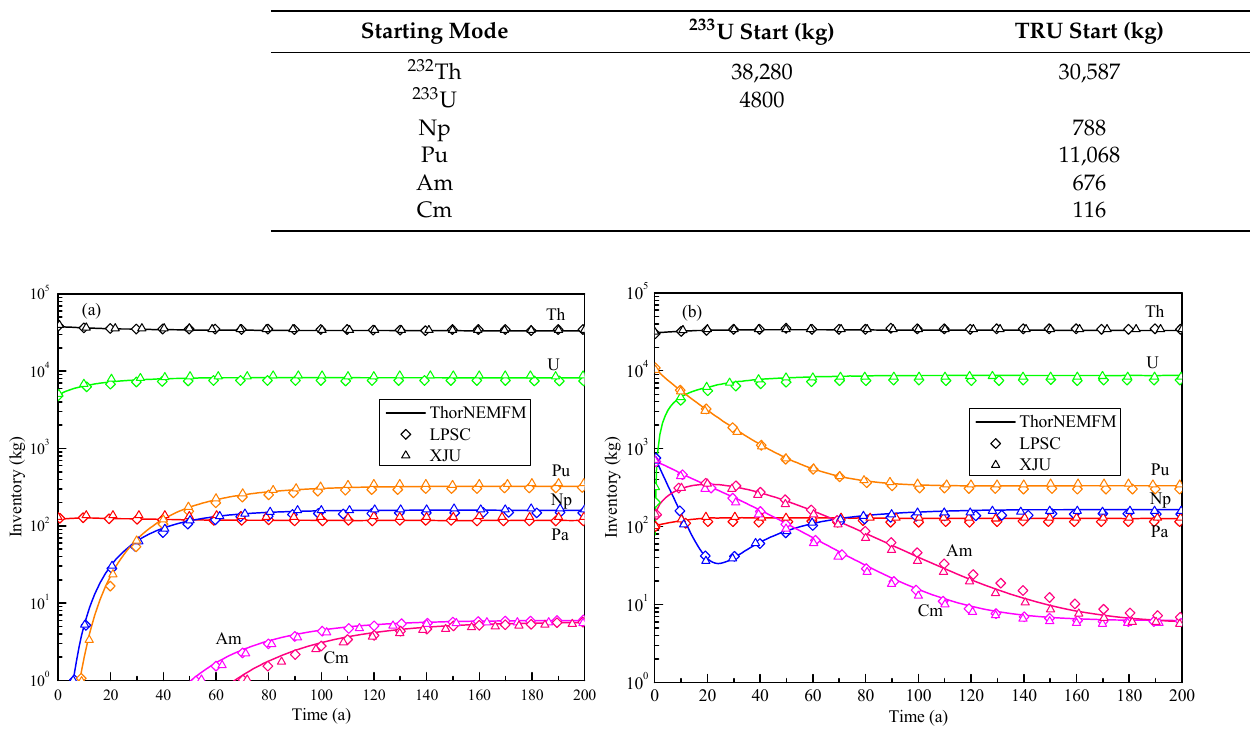
Figure 5. Overall scheme of the fuel salt management, including the online gaseous extraction system ( top ) and the offline reprocessing unit ( bottom ) [10]. Table 4. Initial heavy nuclei inventories of different MSFR starting modes.